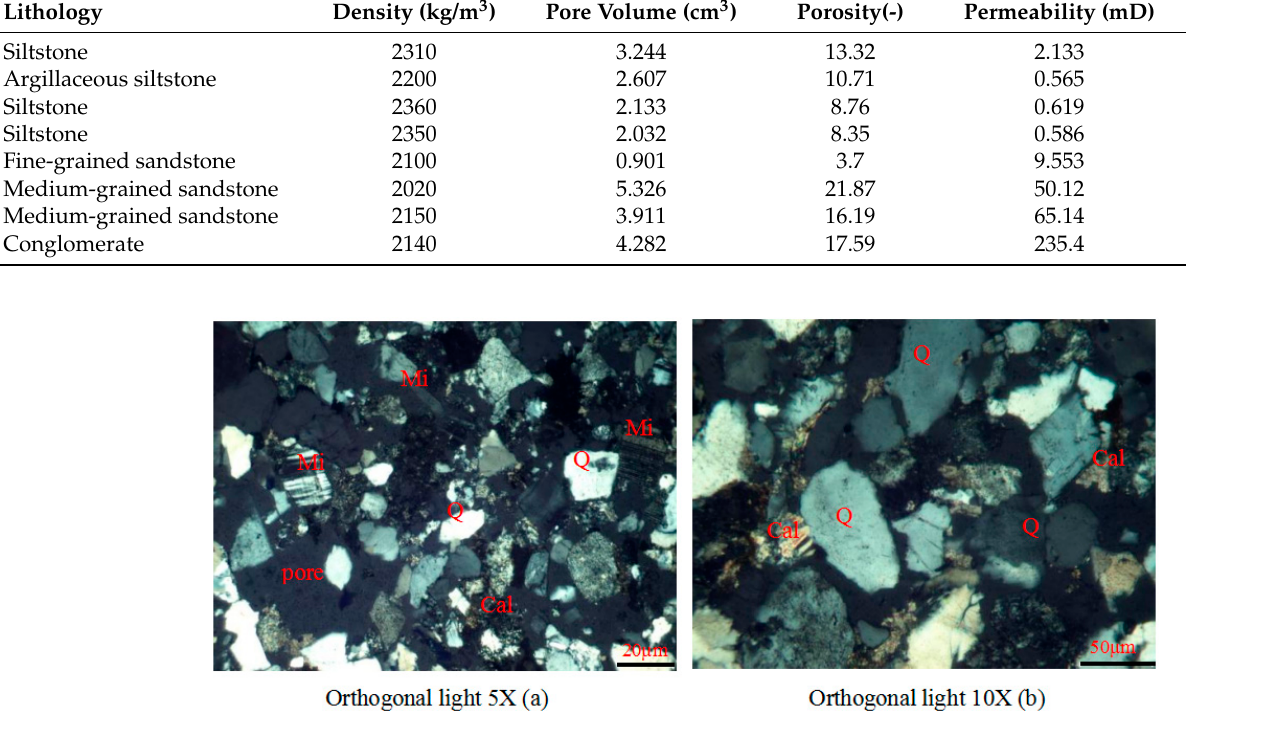
Figure 1. Microstructure of the medium-grained sandstone in the study region (Mi—microcline, Qz—quartz, Cal—calcite).